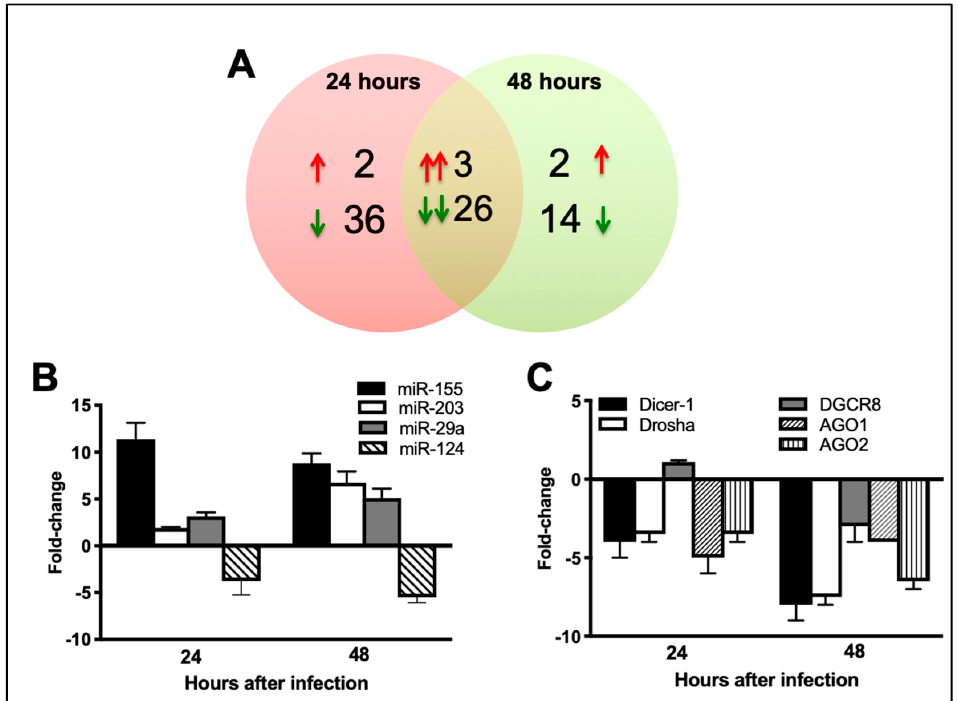
Figure 2. ZIKV infection of the primary mouse neurons causes changes in cellular miRNA expression. Neurons were infected with ZIKV (PRVABC59 strain) or PBS (Mock) at MOI-1. ( A ) Venn diagram showing the number of differentially expressed miRNAs at 24 and 48 h after infection. Sets of upregulated miRNAs are represented by upward red arrows and sets of downregulated miRNAs are represented by downward green arrows. Pairs of arrows in the intersection refer to the number of miRNAs upregulated (double red arrows) or down regulated (double green arrows) at both 24 and 48 h after infection. ( B ) qRT-PCR was conducted on RNA extracted from mock and ZIKV-infected neurons to determine fold-change in miR-155, miR-203, miR-29a, and miR-124-3p expression. Changes in the levels of each miRNA were first normalized to the snoRNA and then the fold-change in ZIKV-infected cells was calculated in comparison to corresponding mock-infected cells. Data represents the mean ± SEM. ( C ) qRT-PCR was conducted on RNA extracted from mock and ZIKV-infected neurons to determine fold-change in Dicer-1, Drosha, DGCR8, AGO1, and AGO2 expression. Changes in the levels of each mRNA were first normalized to the β -actin and then the fold-change in ZIKV-infected cells was calculated in comparison to corresponding mock-infected cells. Data represents the mean ±